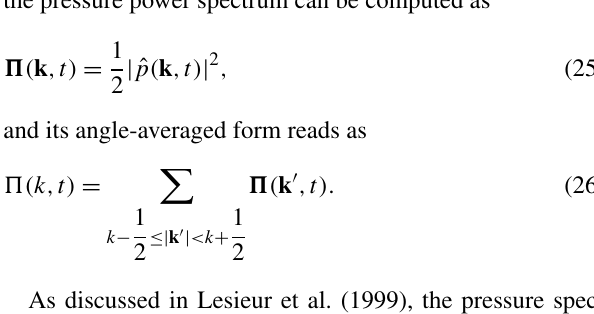
√ ρ u , (c) compensated solenoidal √ ρ u